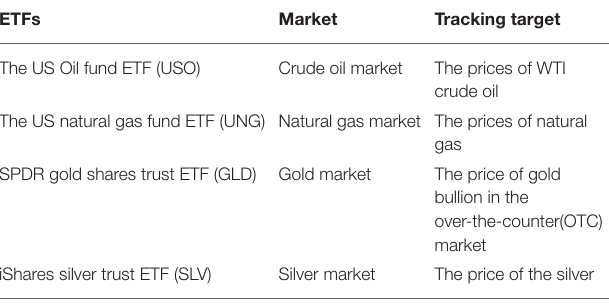
TABLE 1 | The selection of exchange traded funds (ETFs). ETFs